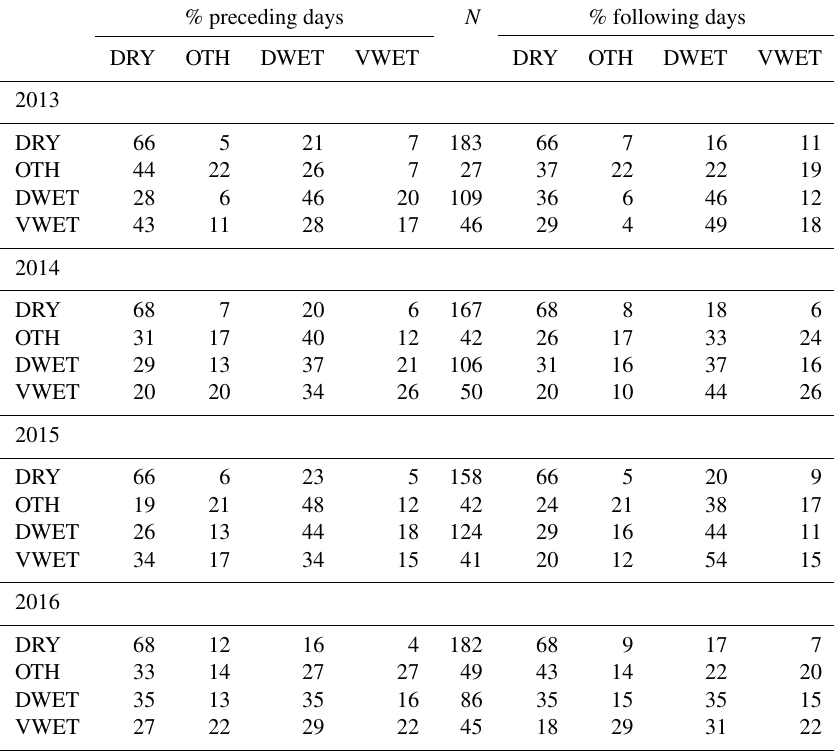
Table 2. Percentages of the types of day which came immediately before and after each type, broken down by observation year. N denotes the number of days of each type in each year. OTH denotes days classified as WET but not DWET, so that the OTH and DWET categories combine to make up the WET category. The data from each year are presented separately to give an indication of inter-annual variation. To give an example from the last line of the table, in 2016 there were 45 VWET days, and 27% of the days in 2016 directly preceding VWET days were DRY, compared to 18% of the days directly following VWET